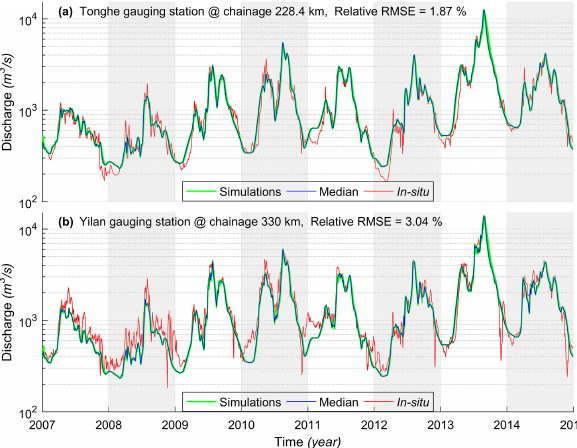
Figure C1. Validation of simulated discharge at two gauging stations. Note, in each plot, results of the median and individual simulations of an ensemble of 30 calibrations (i.e., calibrations #1, #2, and #3) are shown.